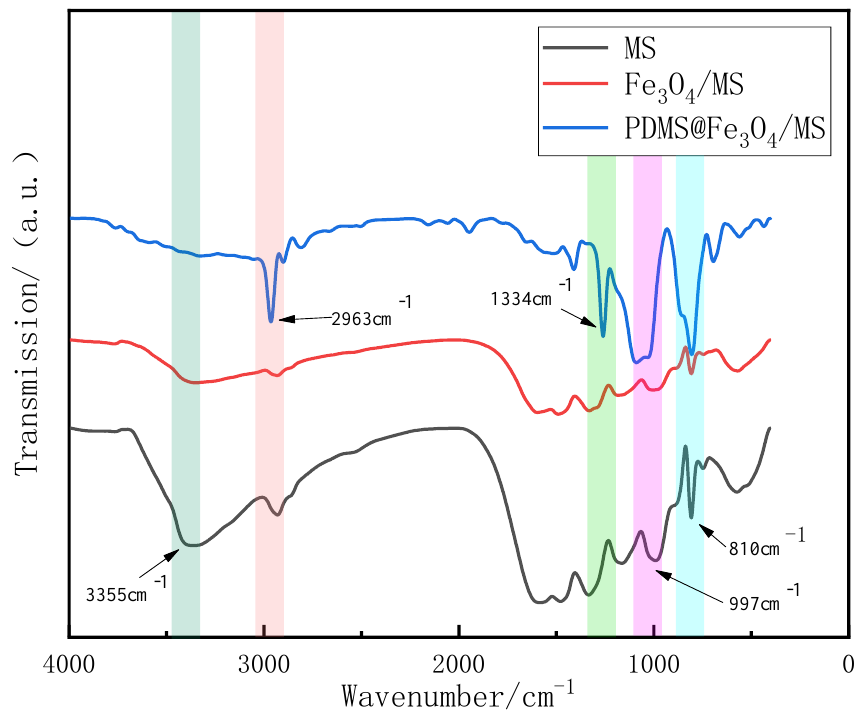
Figure 6. FTIR diagrams of MS, Fe 3 O 4 /MS and PDMS@Fe 3 O 4 /MS (The shadows from left to right are 3355 cm − 1 , 2963cm − 1 , 1334 cm − 1 , 997 cm − 1 and 810 cm − 1 ).